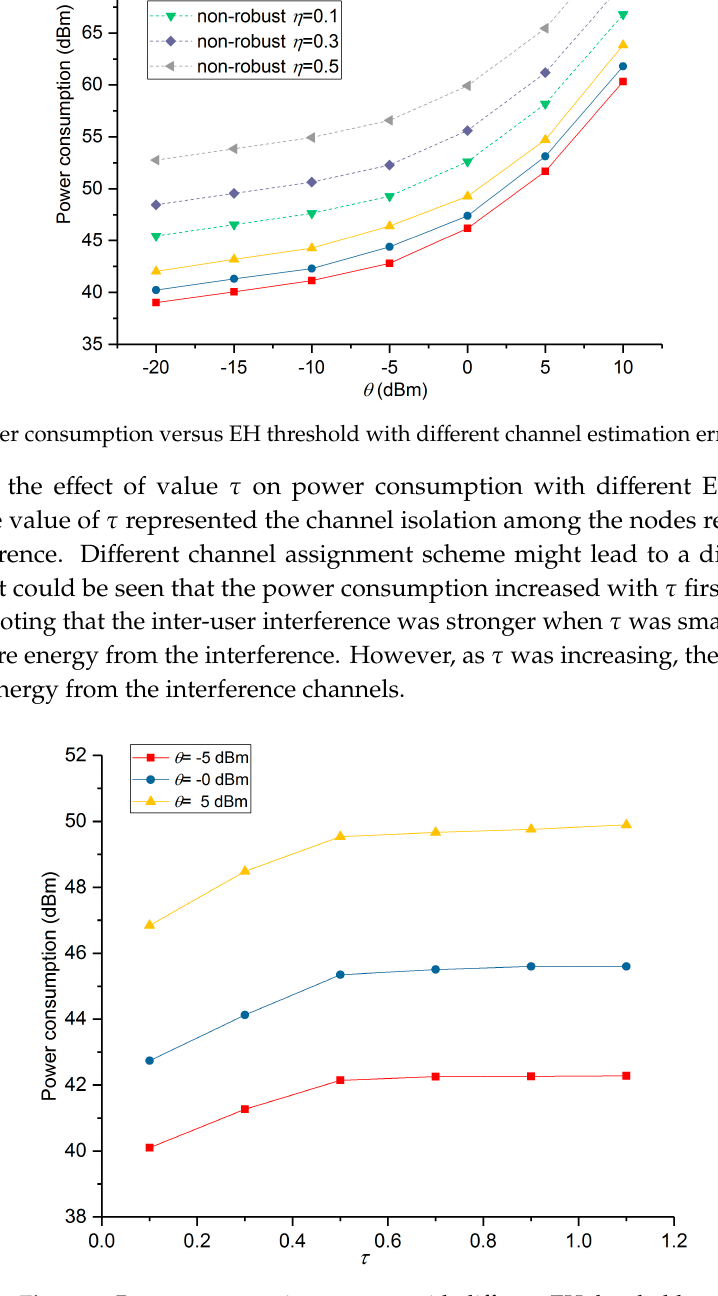
Figure 5. Power consumption versus τ with di ff erent EH